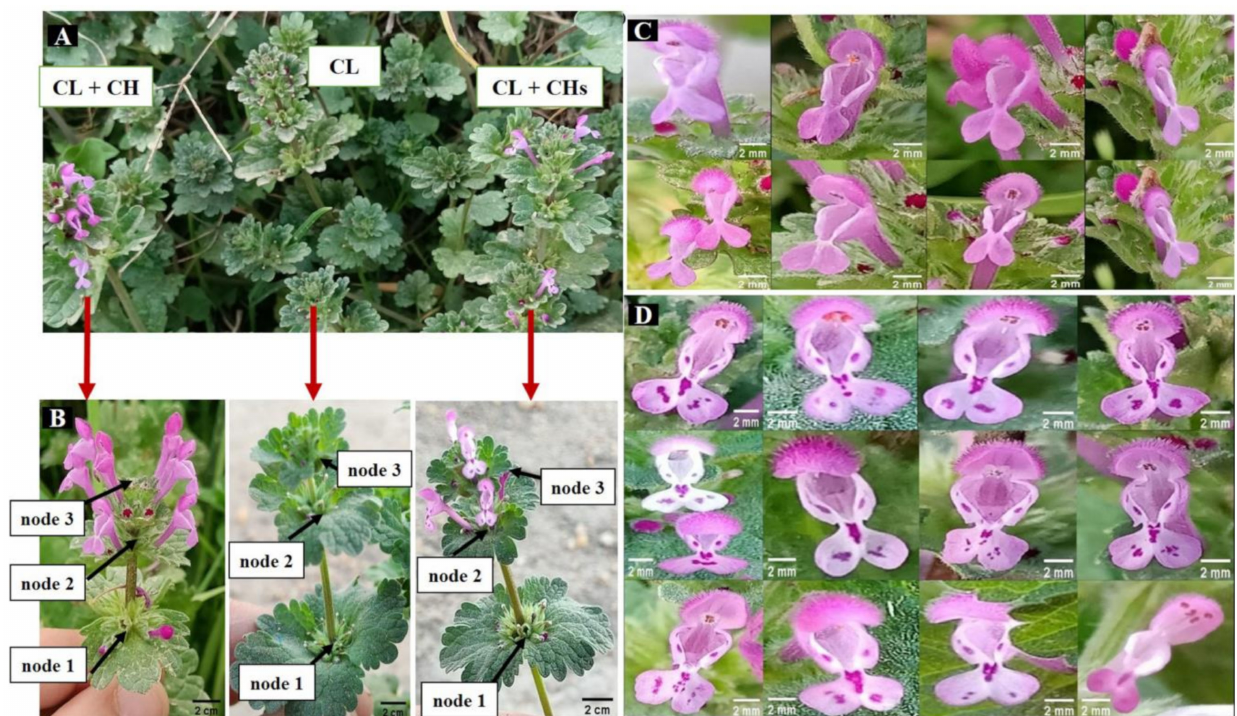
Figure 1. General features of the traced L. amplexicaule morphs ( A ) Three morphs coexist in the same population in the winter season ( B ) Virtual plasticity in the proportions of CL and CH flow- ers/node/morph ( C ) Corolla of the CH flowers in CL + CH morph showed diversity in color, size, and shape ( D ) Corolla of the CH flowers in CL + CHs morph showed diversity in color, size, shape and the number of spots.